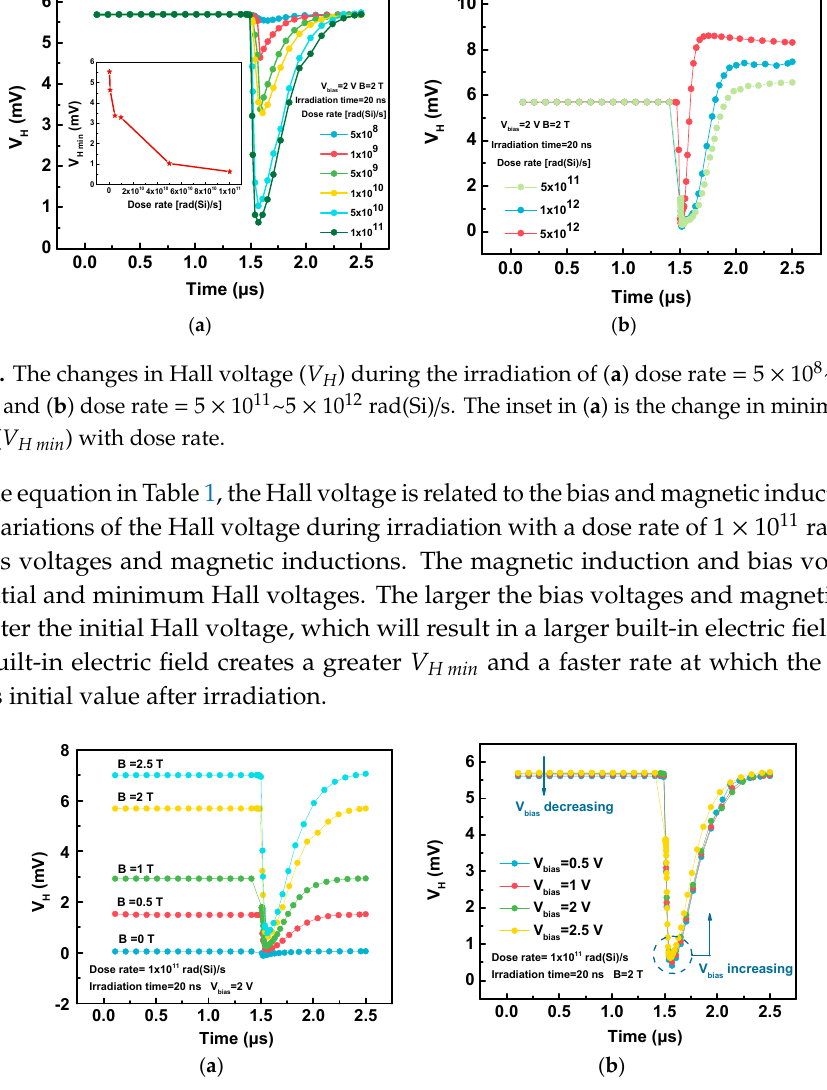
Figure 7. During irradiation with a dose rate of 1 × 10 11 rad(Si)/s, the variations of Hall voltage ( V H ) under different ( a ) magnetic inductions ( B ), and ( b ) bias voltages ( V bias ).